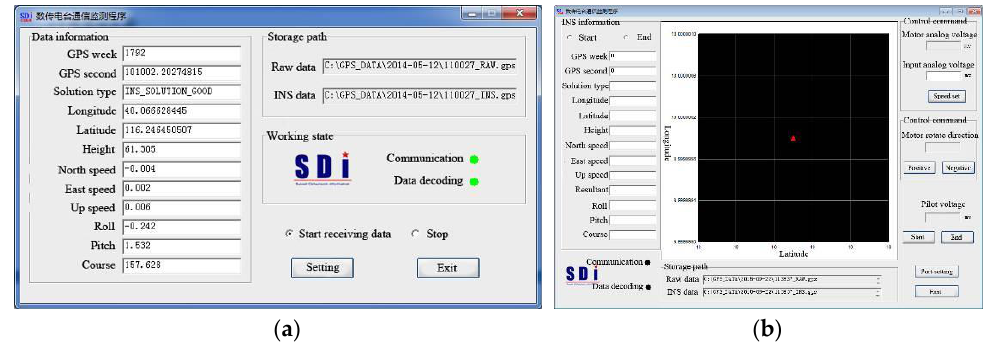
Figure 21. User interface of remote control and monitoring system: ( a ) on the model; and ( b ) on the escort yacht.